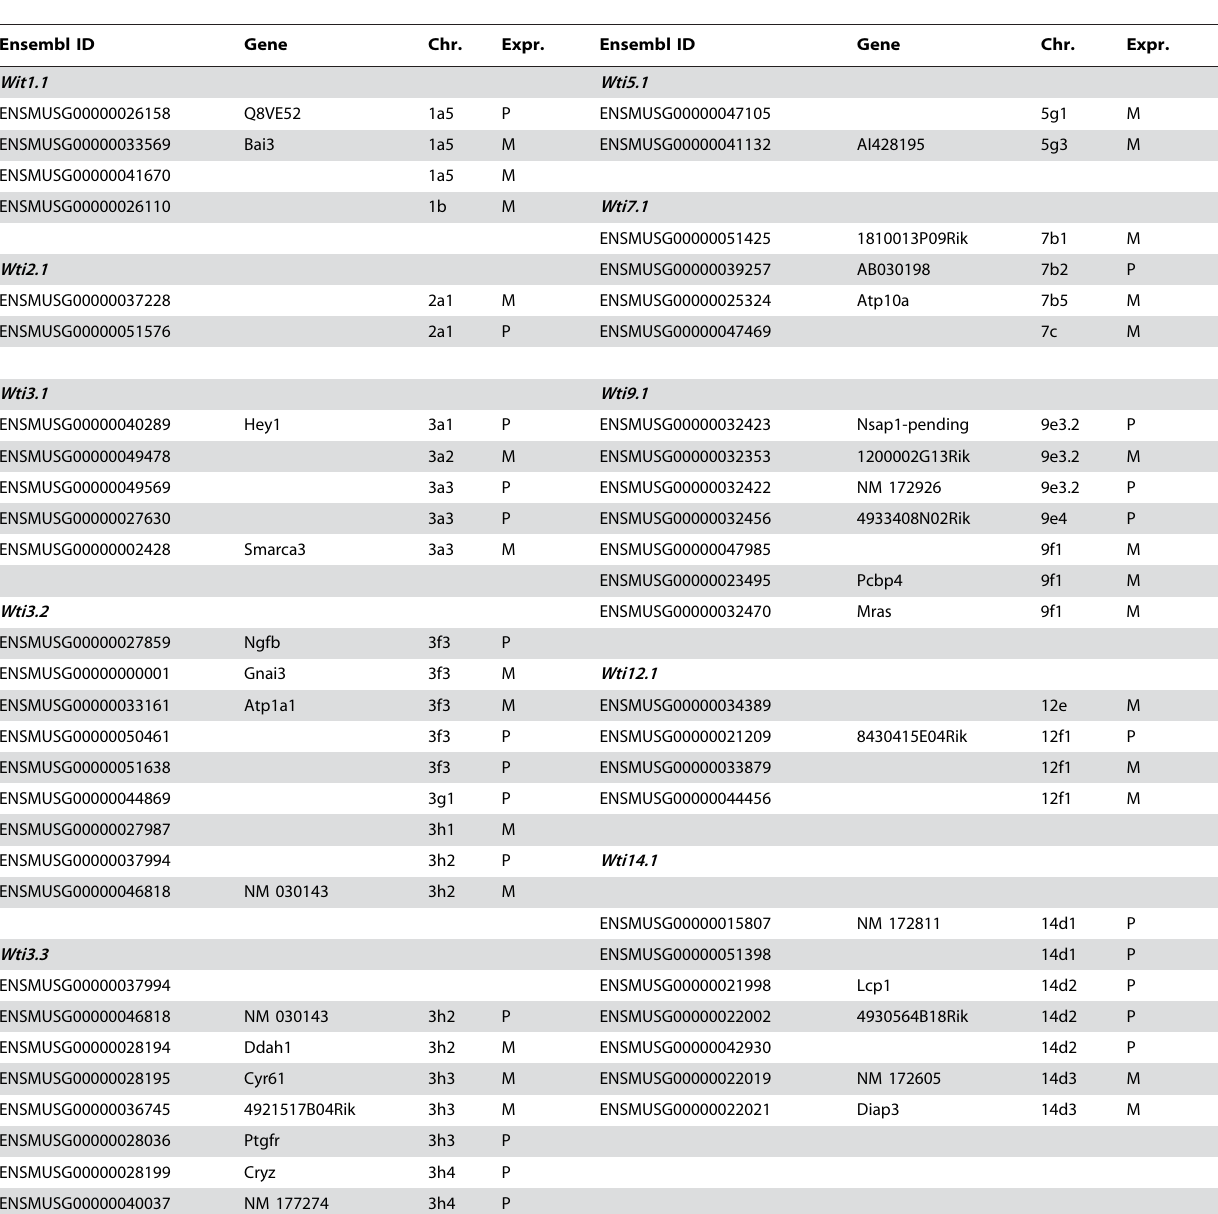
Table 2. Predicted imprinted genes (Luedi et al. 2005) lying within the confidence regions of our i QTL.